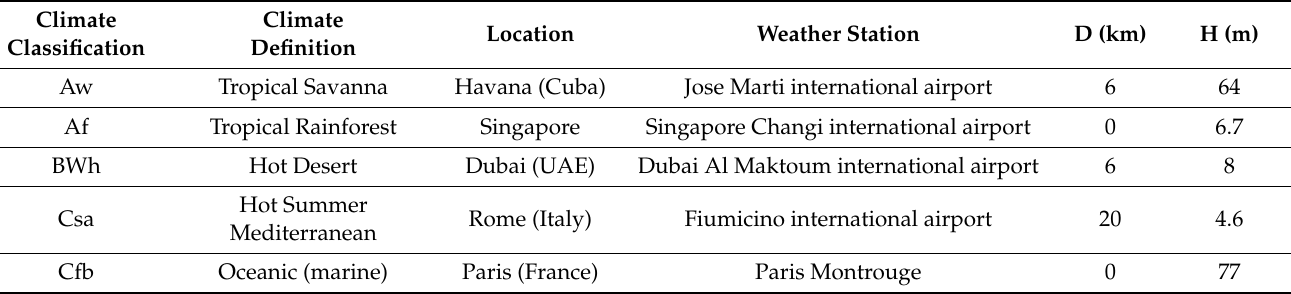
Table 1. Climate classifications and related